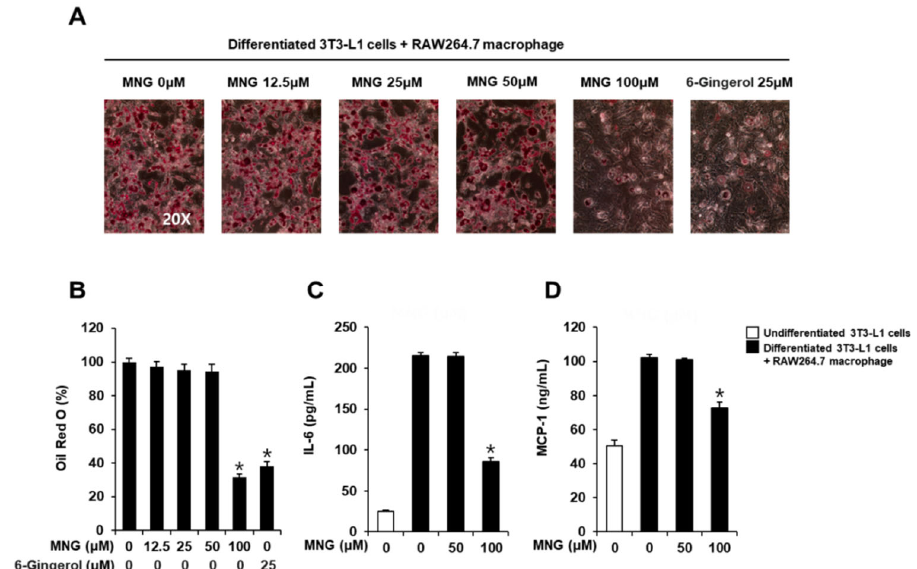
Figure 3. Inhibitory effects of the MNG on lipid accumulation and production of IL ‐ 6 and MCP ‐ 1 in co ‐ culture conditions with 3T3 ‐ L1 and RAW264.7 cells. ( A ) Images of Oil Red O staining representing lipid accumulation and ( B ) levels of Oil Red O staining in co ‐ culture condition with 3T3 ‐ L1 and RAW264.7 cells treated with the indicated concentration of MNG and 6 ‐ gingerol (positive control). Analysis of levels of the proinflammatory cytokine ( C ) IL ‐ 6 and ( D ) MCP ‐ 1 in co ‐ culture conditions with 3T3 ‐ L1 and RAW264.7 cells treated with the indicated concentration of MNG and 6 ‐ gingerol ( n = 3 independent experiments, * p < 0.05, Kruskal–Wallis nonparametric test). Data represent the mean ± SEM.